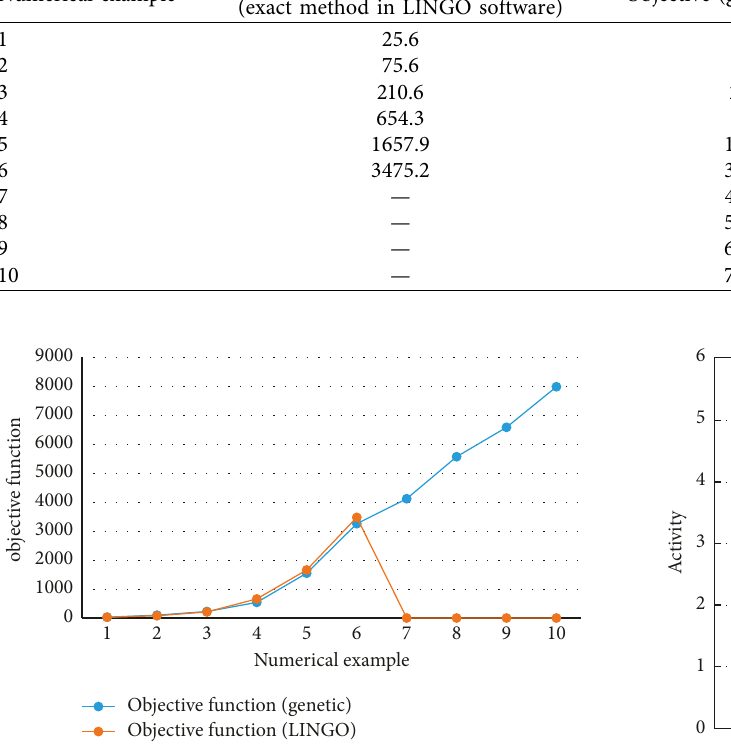
Figure 1: Change in the objective function in the genetic and LINGO methods with an increasing dimension of the problem.